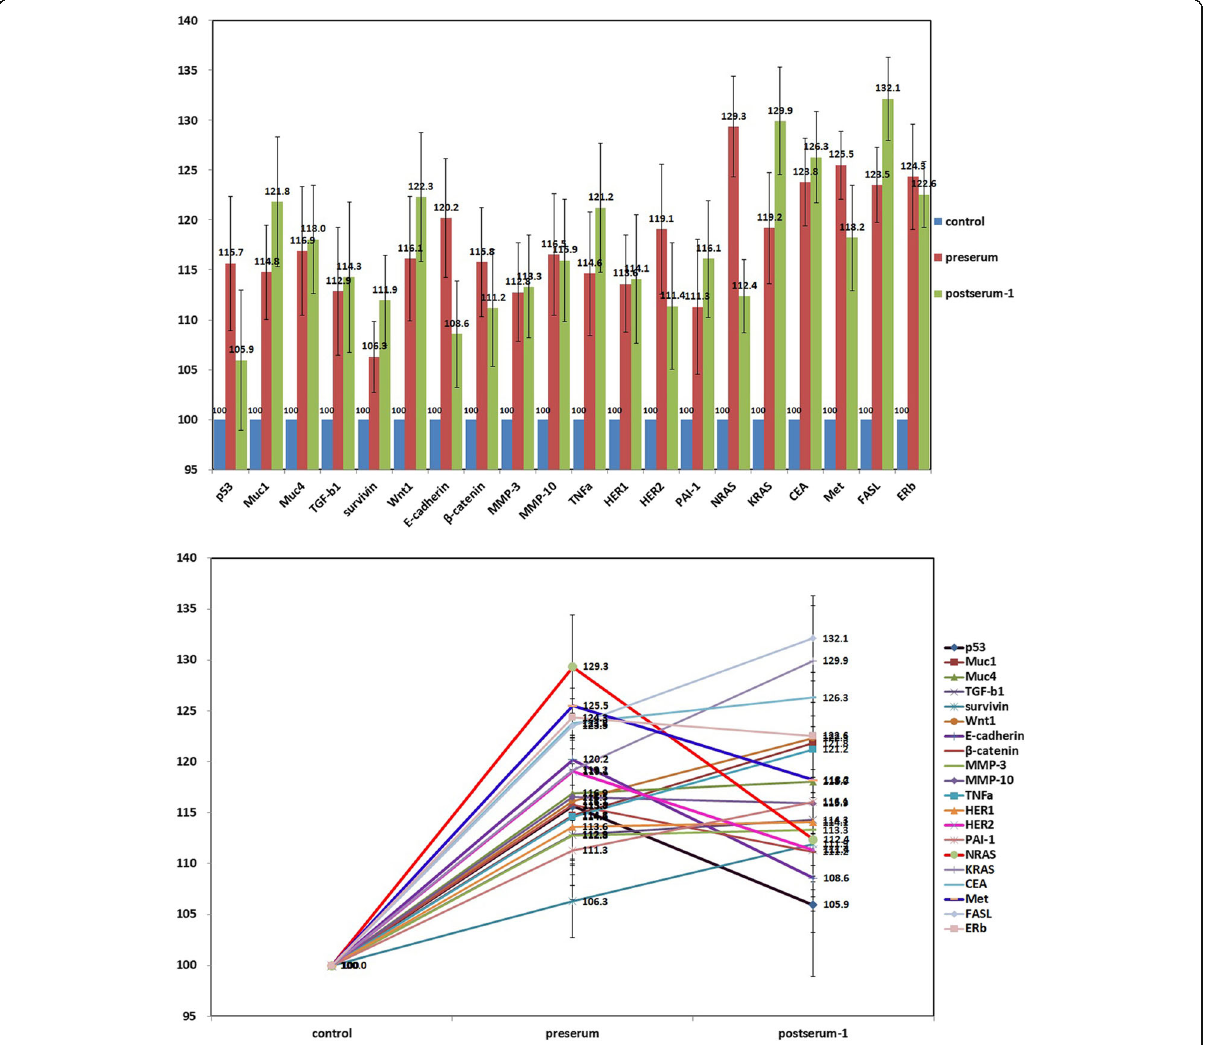
Fig. 3 An upper bar graph and a lower line graph comparing oncogenic protein expression profiles between preoperative and postoperative day 10